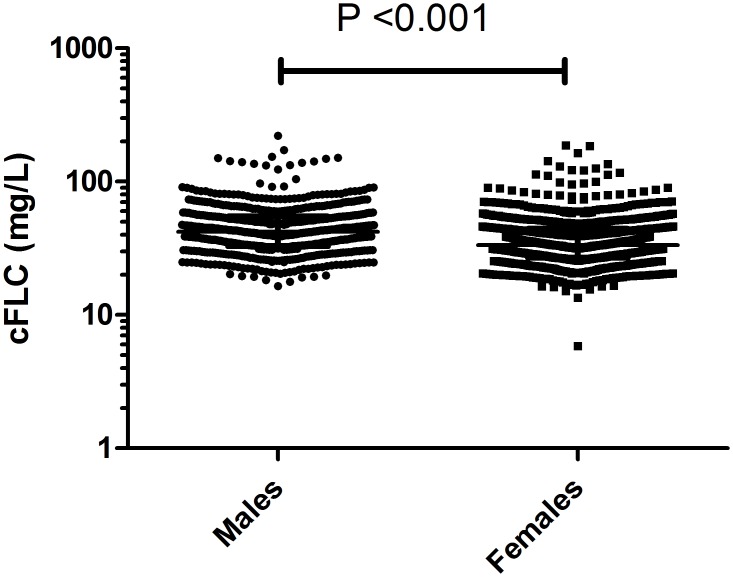
cFLC concentrations in males and females.cFLC concentrations were compared and were elevated in males compared to females (P<0.001). Median and interquartile ranges are indicated.